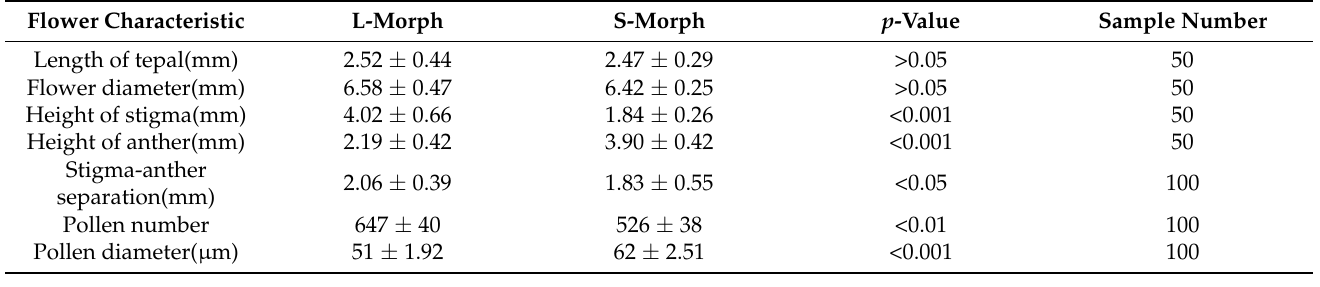
Figure 3. Flowers of the L- and S-morphs of P. criopolitanum (( A , C ): L-morph; ( B , D ): S-morph). Table 1. Morphological features of the long- and short-morph flowers of P.criopolitanum . Differences between the means were analyzed using one-way analysis of variance (ANOVA; mean ± standard error).